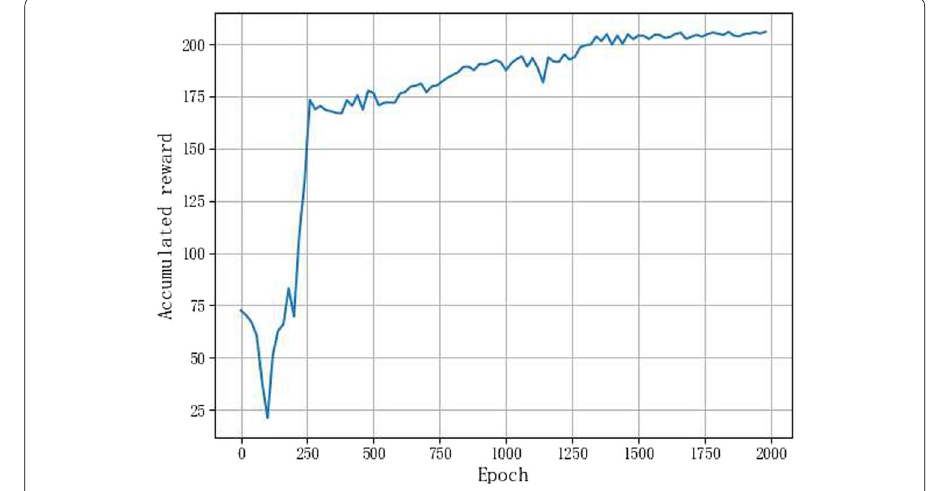
Fig. 6 Learning curve of DQN algorithm